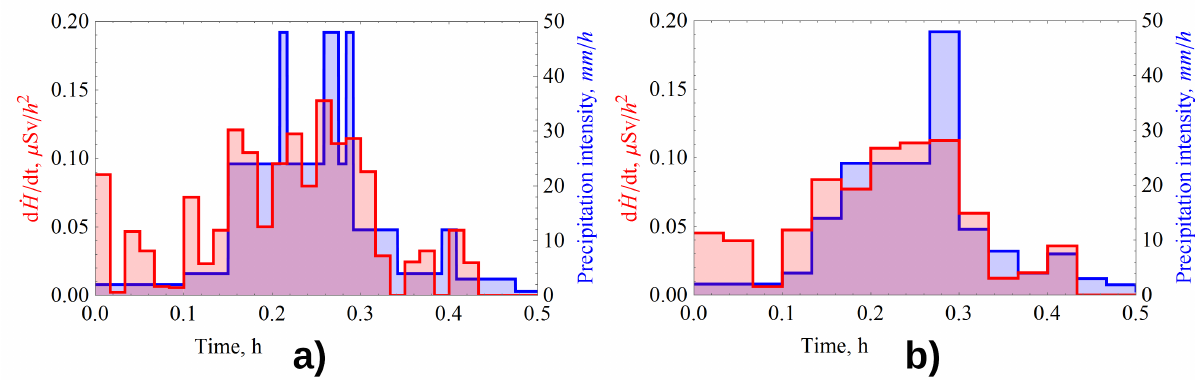
Figure 8. Dynamics of the time derivative of the measured dose rate (red) and intensity of precipitation on 11 June (blue) with averaging: ( a ) 1 min; ( b ) 2